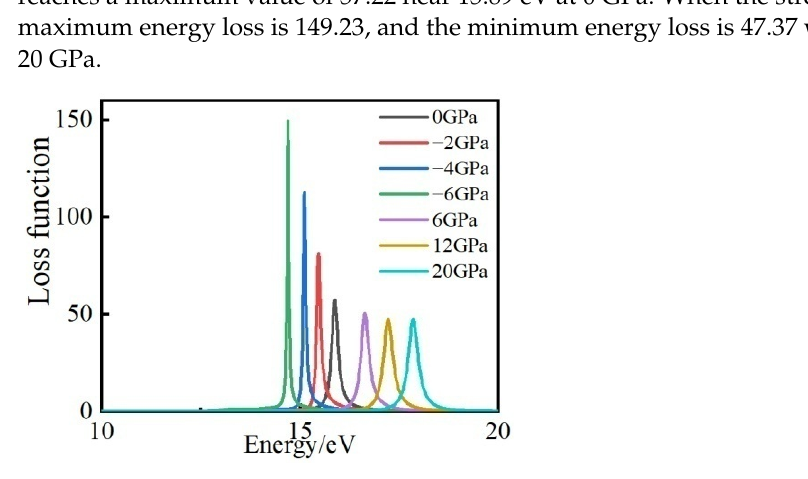
Figure 10. The energy loss function .